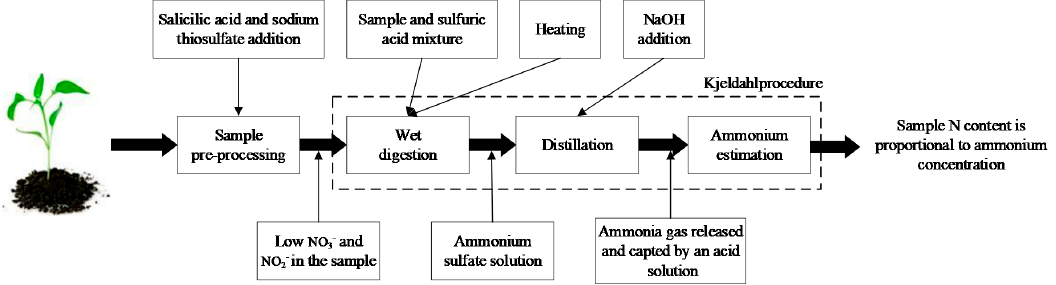
Figure 1. Kjeldahl wet digestion procedure.